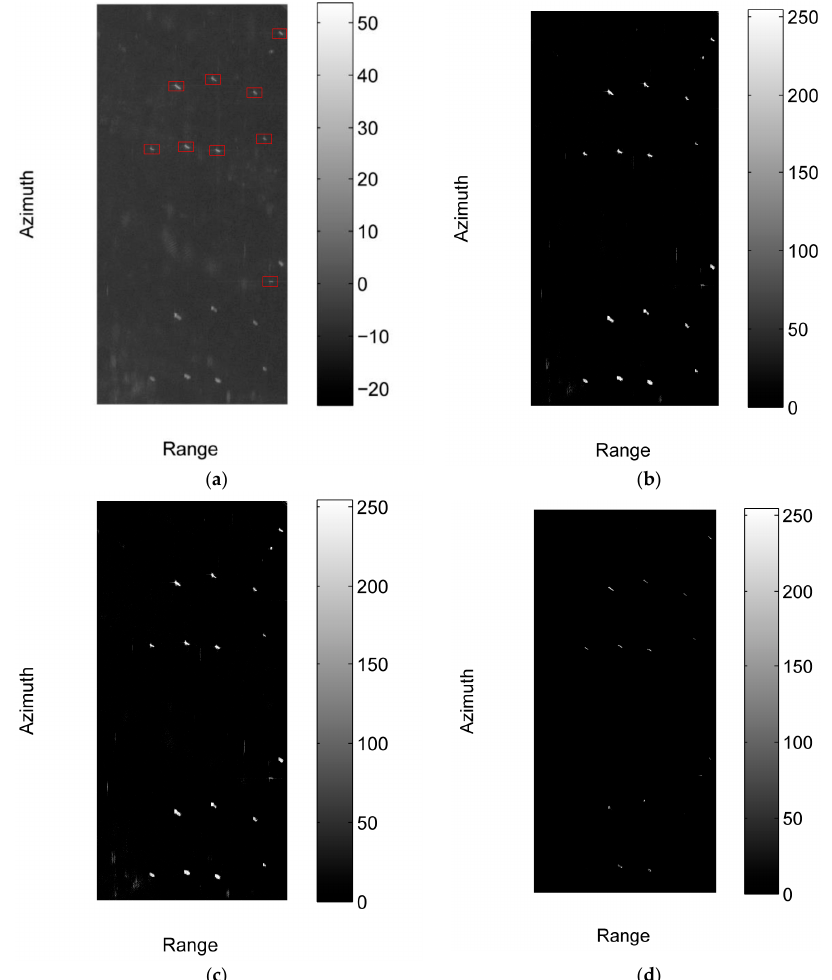
Figure 8. Comparison of detected results of various methods on sub-image #2. ( a ) Detected result of the proposed method, and the intensity of the image in dB is shown in this figure; ( b ) Detected result of the TS-SEG-CFAR method; ( c ) Detected result of the IICS method; ( d ) Detected result of the SLIC-CFAR method.